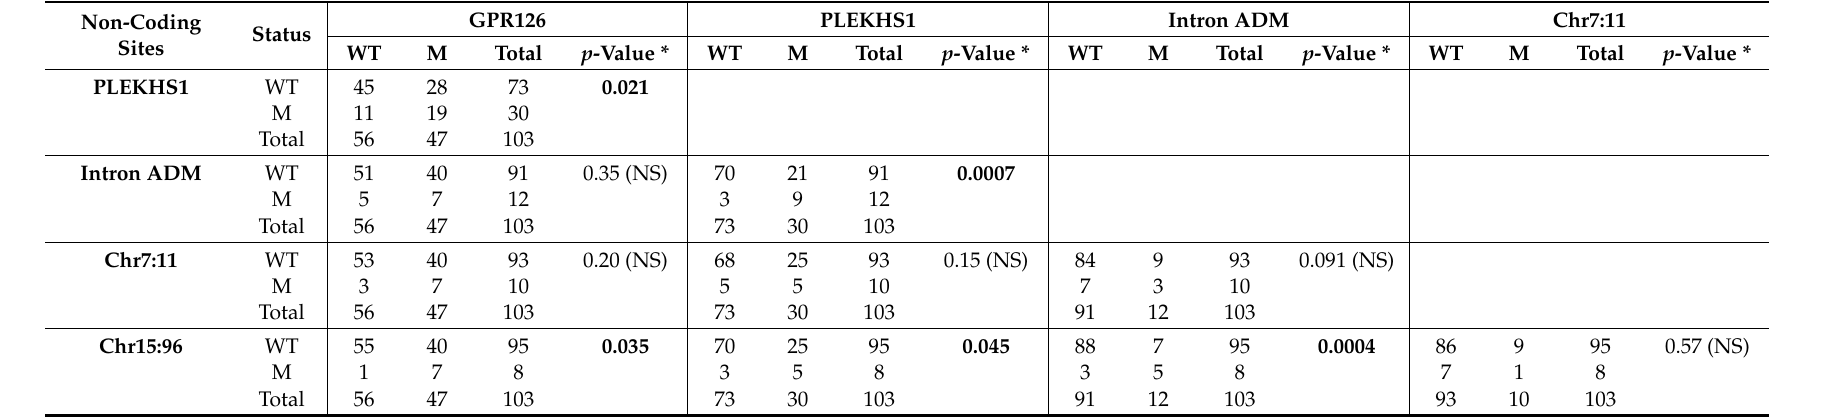
Figure 2. Needle-plots of recurrent mutations along the sequences of selected non-coding and palindromic regions. Palindromic sequences are highlighted in red. Table 3. Co-occuring mutations between the 5 most frequently mutated non-coding